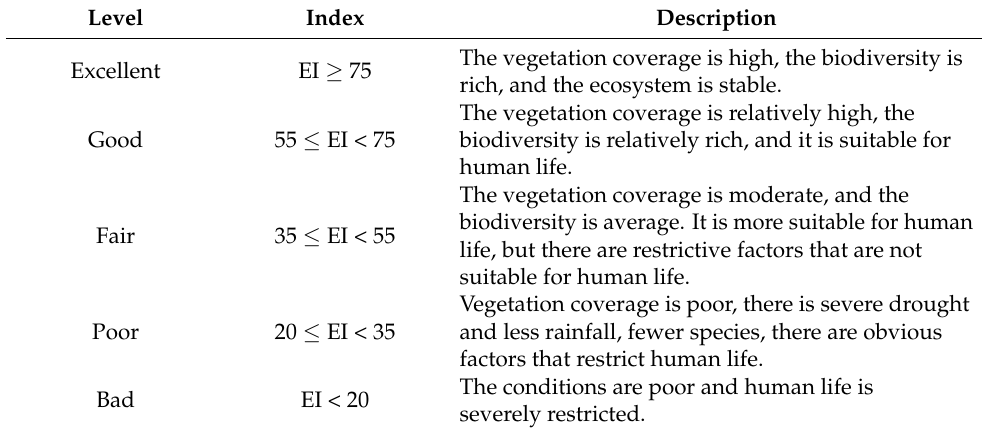
Table 6. Classification of EI based on ecological quality.